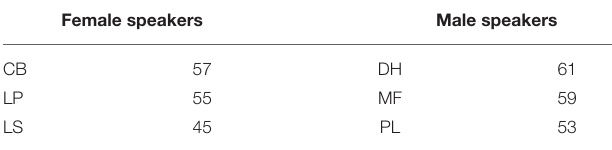
TABLE 4 | PASCAL scores for the different speakers in the sample (out of 100). Female